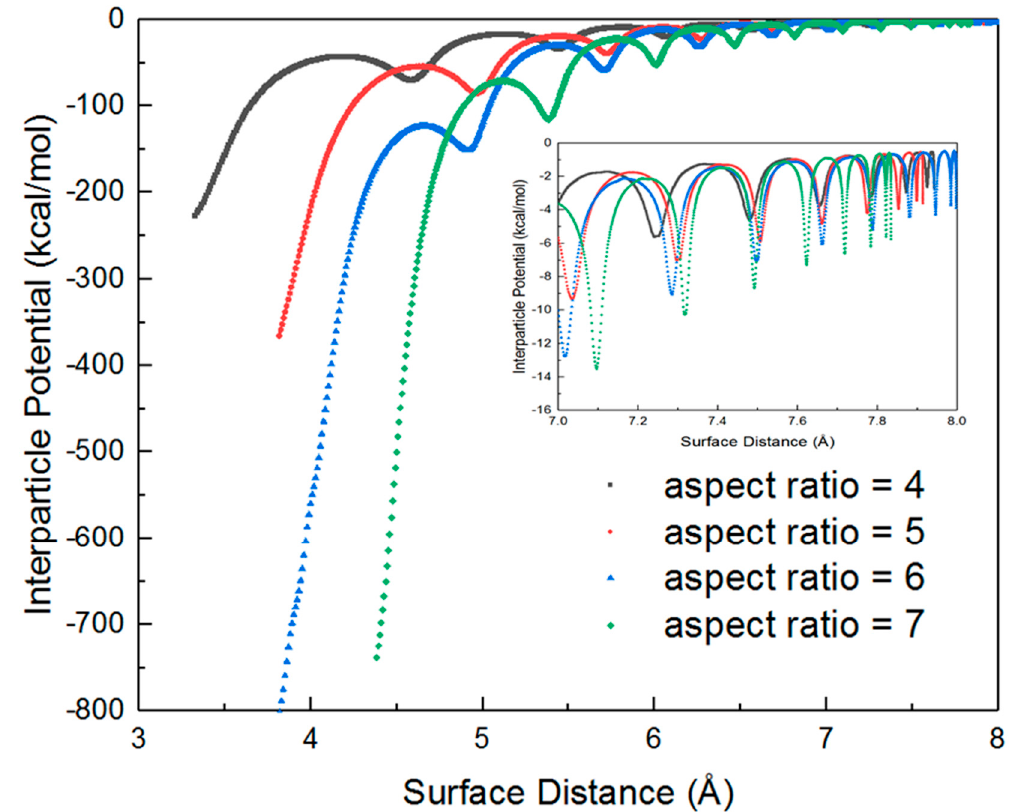
Figure 3. Interparticle potential as a function of surface separation of AuNRs with a diameter of 2 nm and different aspect ratios (L/D): 4 (black), 5 (red), 6 (blue), and 7 (green); the insert is the interparticle potential as a function of surface separation at very early stage (i.e., 0.7–0.8 nm).